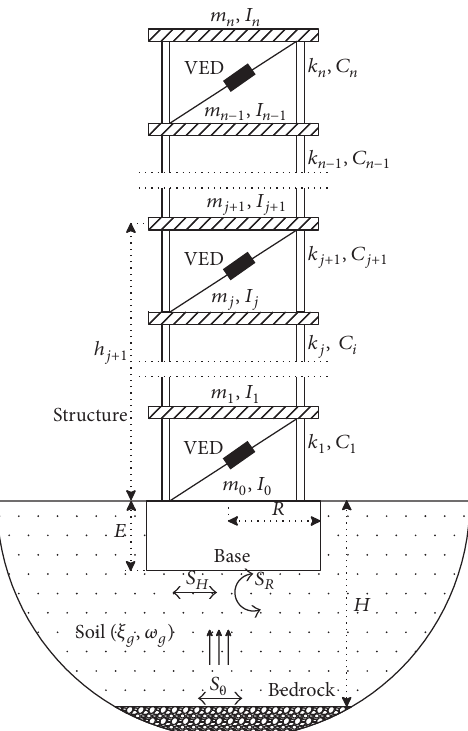
Figure 1: The model of frame structure with VEDs supported by embedment